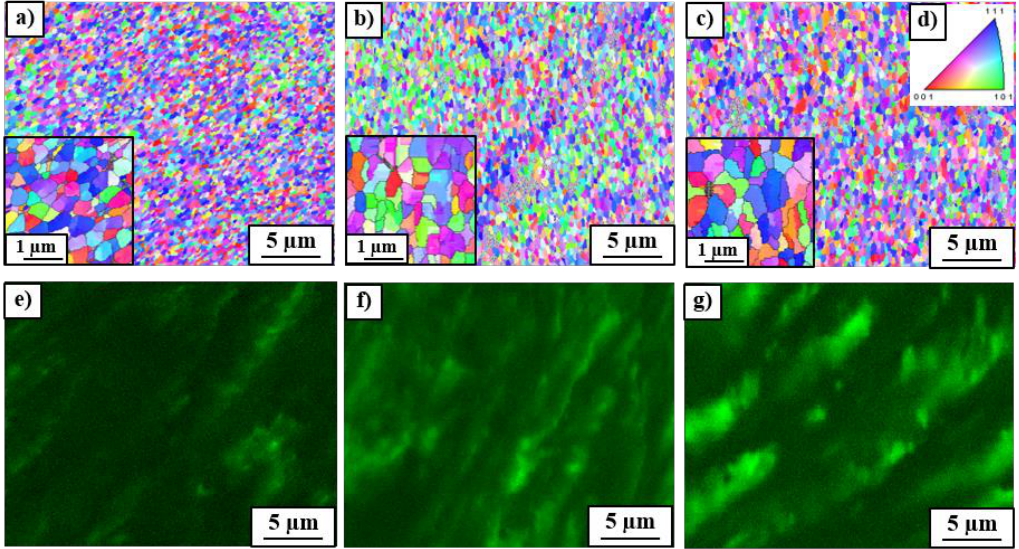
Figure 7. ( a – c ) SEM/EBSD orientation maps and ( e – g ) corresponding Ag distribution (green color) in Cu-matrix (black color) of the Cu–8wt.%Ag alloy after HPT, preliminary annealed at ( a , e ) 400 °C, ( b , f ) 500 °C and ( c , g ) 600 °C together with ( d ) standard unit triangle for fcc α-phase. The inserts inside ( a – c ) display enlarged areas of the EBSD maps with high angle grain boundaries (HAGBs) larger than 10°.